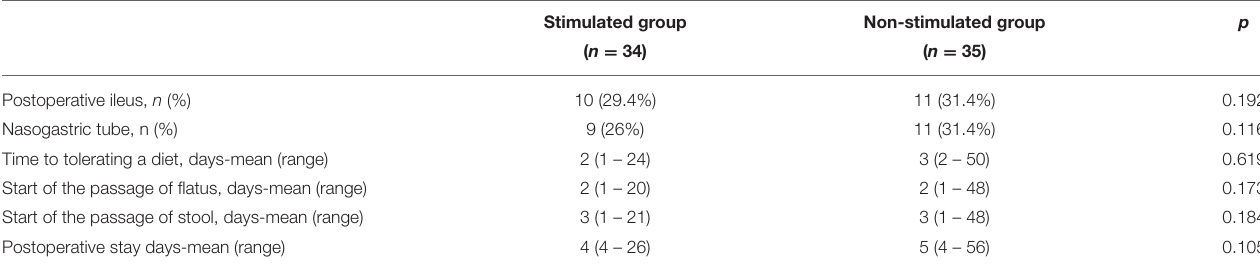
TABLE 2 | Postoperative results.